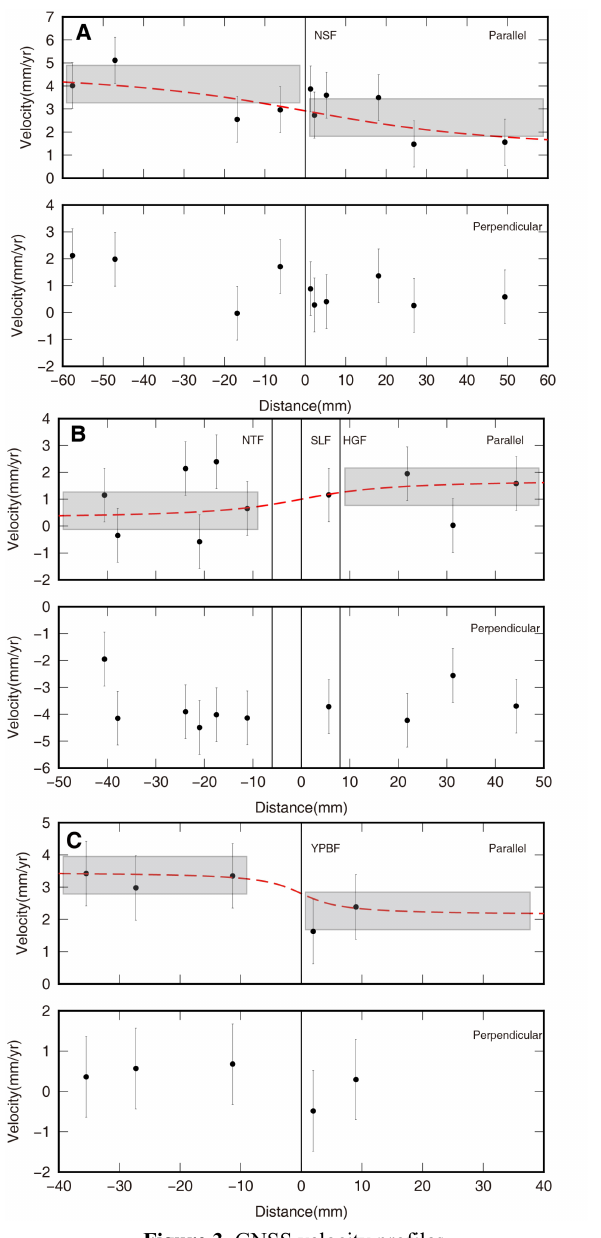
Figure 3 . GNSS velocity profiles. The vertical black solid line shows the fault relative to the velocity profile. Gray box indicates the error range of the fit of arctan